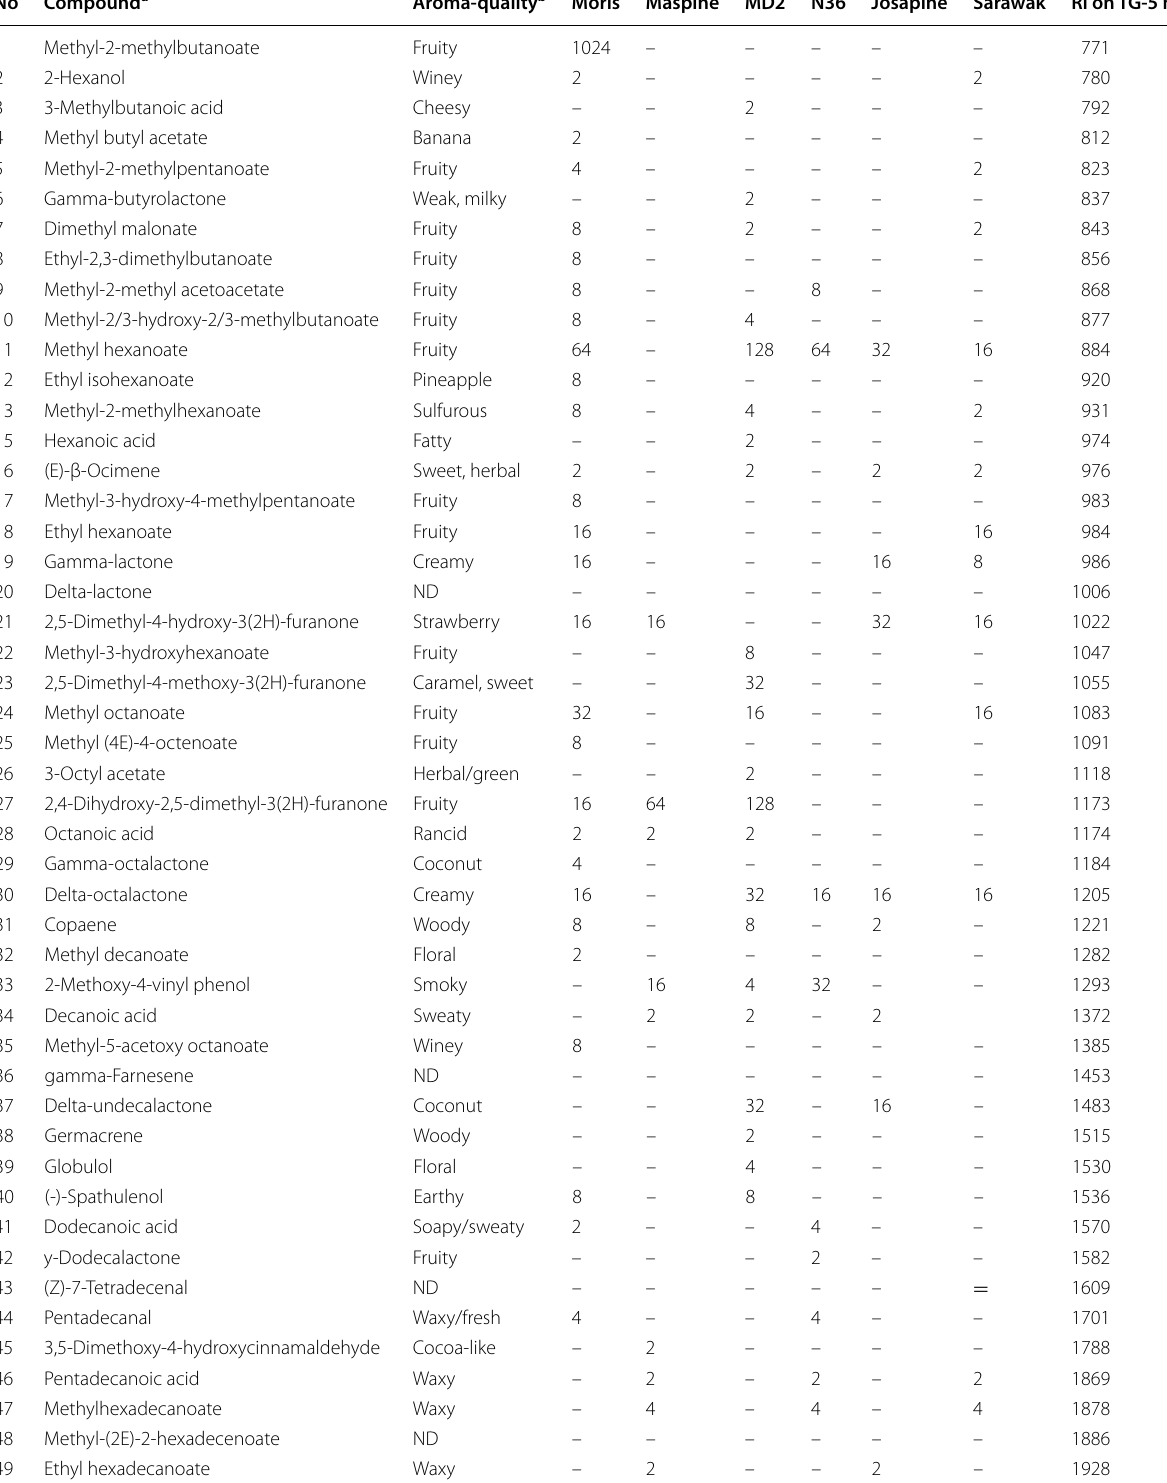
Table 3 Detected aroma compounds with their flavour dilution (FD) factors in each pineapple varieties (Moris, Maspine, MD2, N36, Josapine and Sarawak) grown in